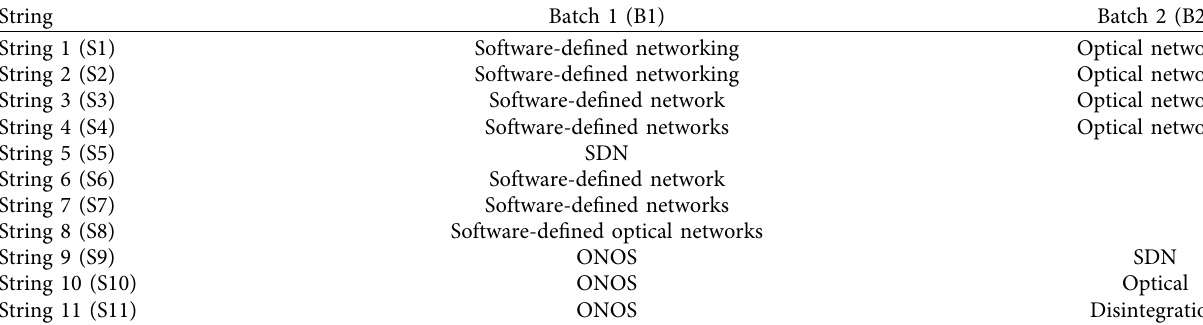
Table 1: Search string